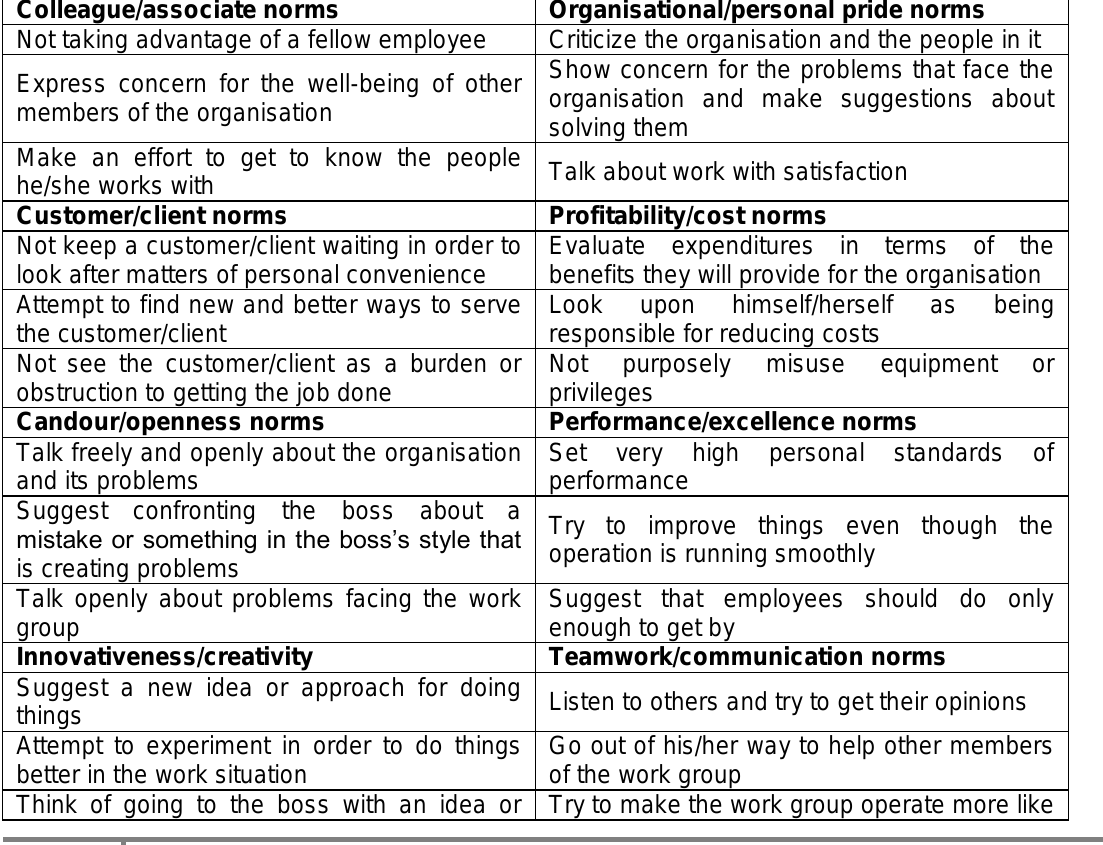
Table 6: Guidelines for nurturing organisational norms Colleague/associate